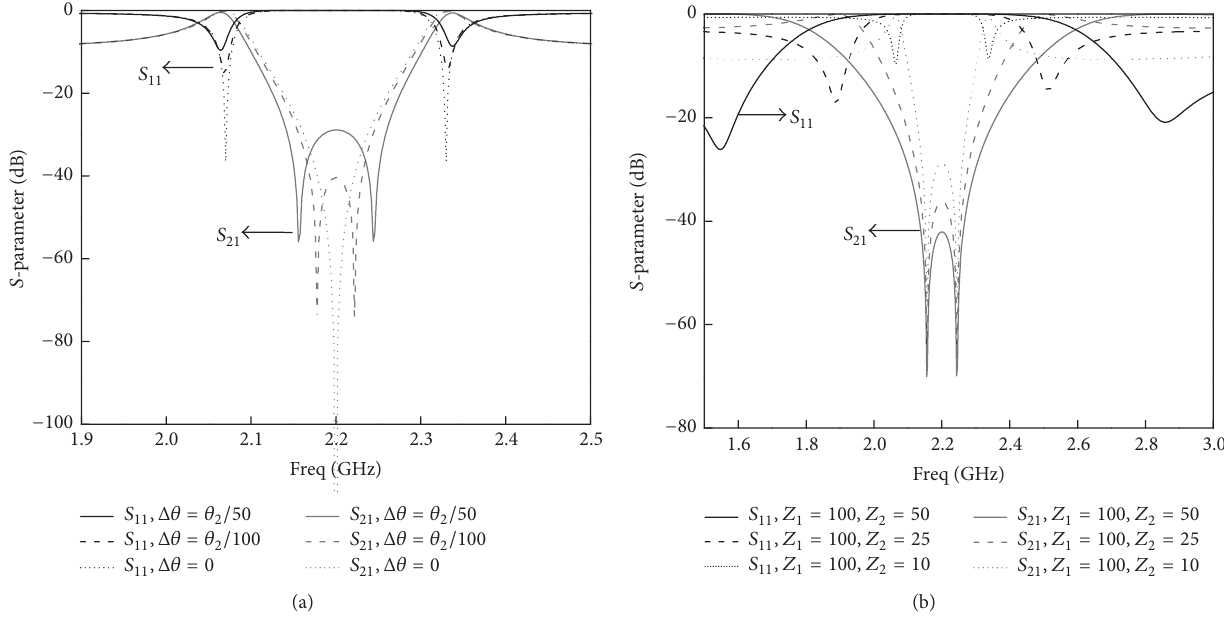
Figure 3: Effect of the Δ𝜃 and impedance ratio. (a) Δ𝜃 ; (b) impedance ratio (in (a), 𝑍 1 = 100 Ω , 𝑍 2 = 10 Ω , 𝜃 2 = 𝜋/2 ; in (b), 𝜃 2 = 𝜋/2 , /50 Δ𝜃 = 𝜃 2